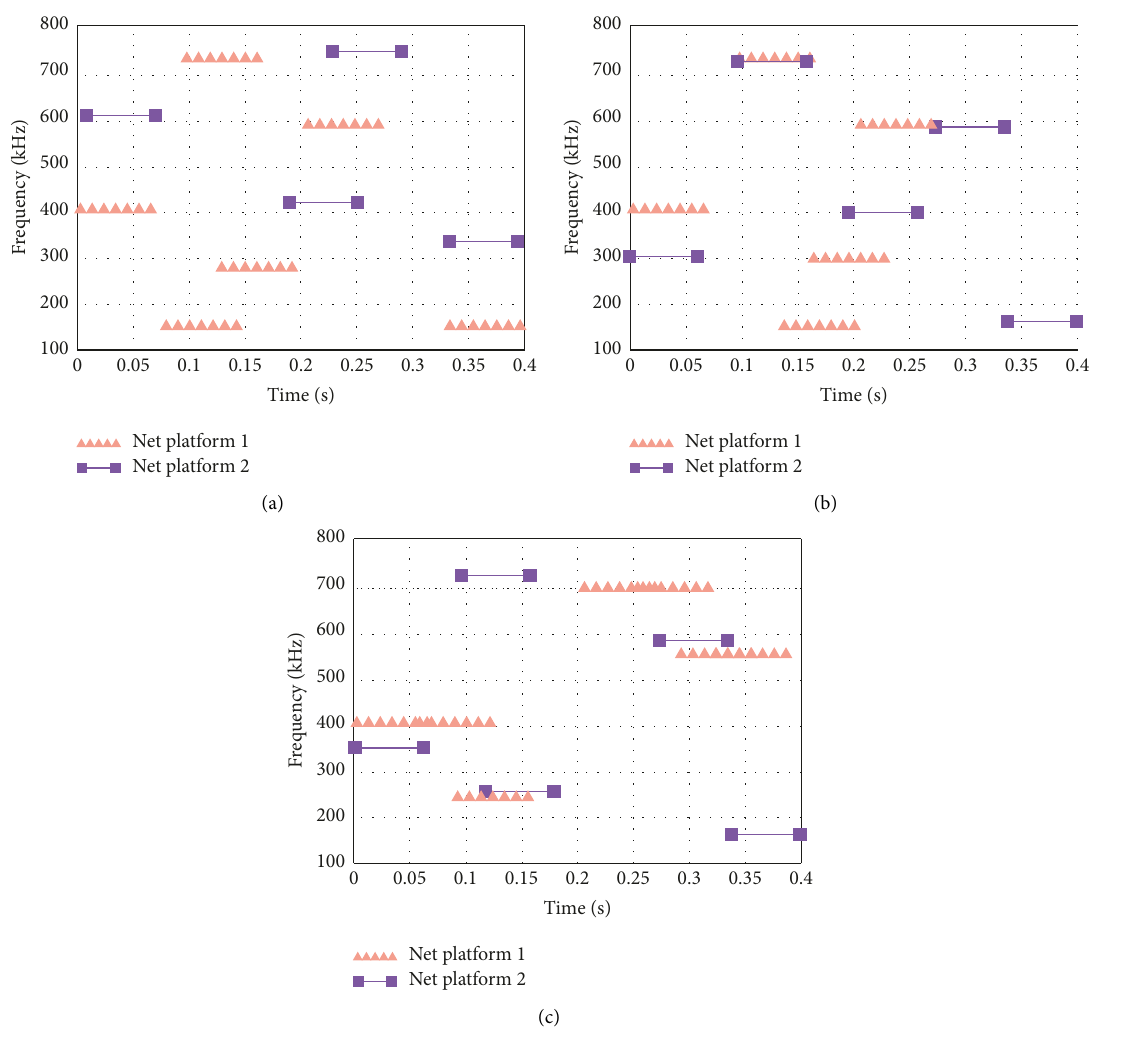
Figure 2: Three types of networking. (a) Synchronous orthogonal networking, (b) synchronous nonorthographic networking, and (c) asynchronous nonorthogonal networking.